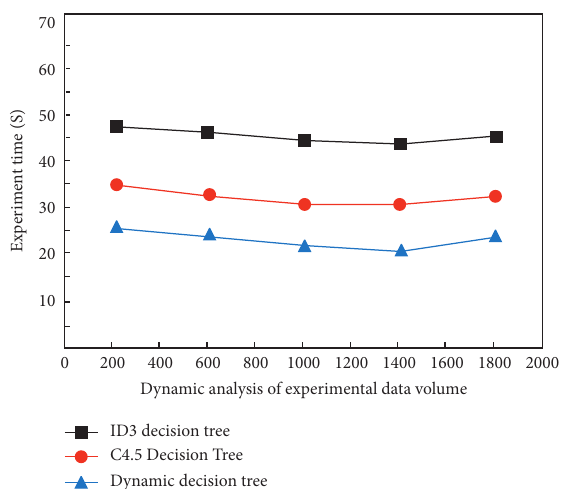
Figure 7: Experimental time for all three types of decision trees.